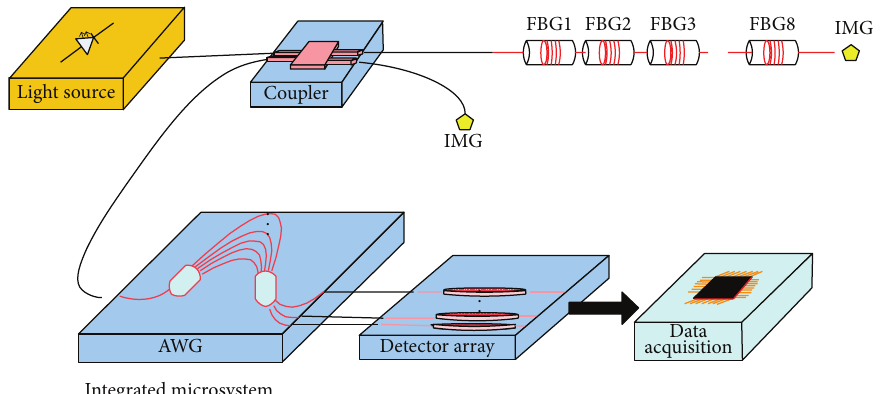
Figure 1: FBG demodulation system based on AWG.